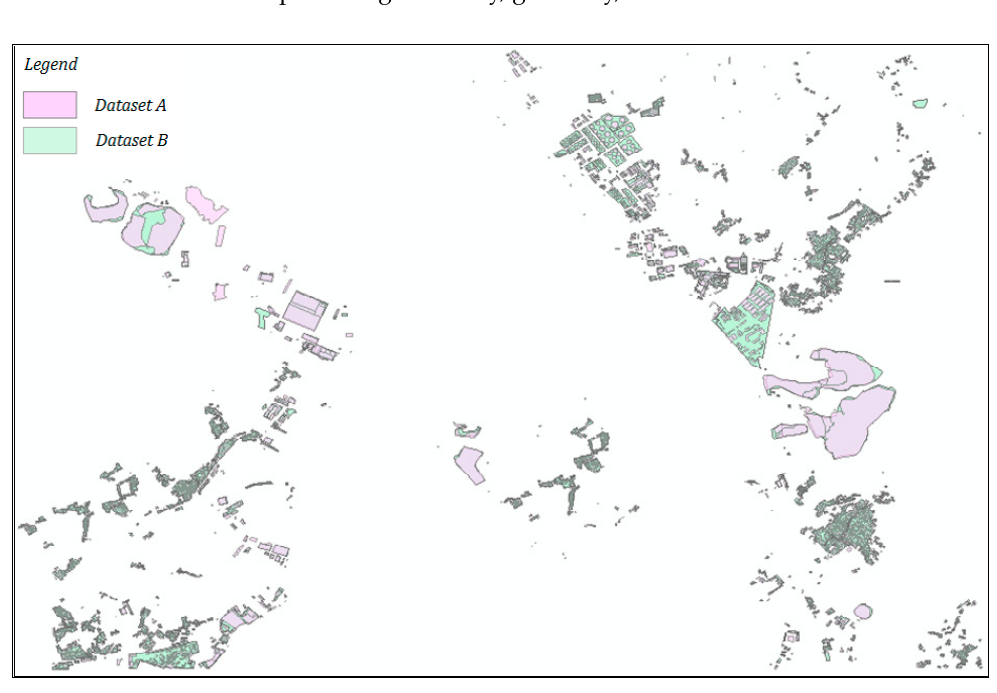
Figure 6. The superposition of dataset 𝑨 and dataset 𝑩